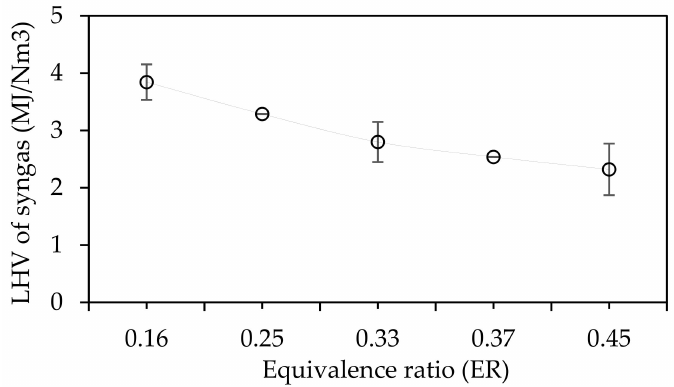
Figure 7. The e ff ect of ER on syngas LHV.